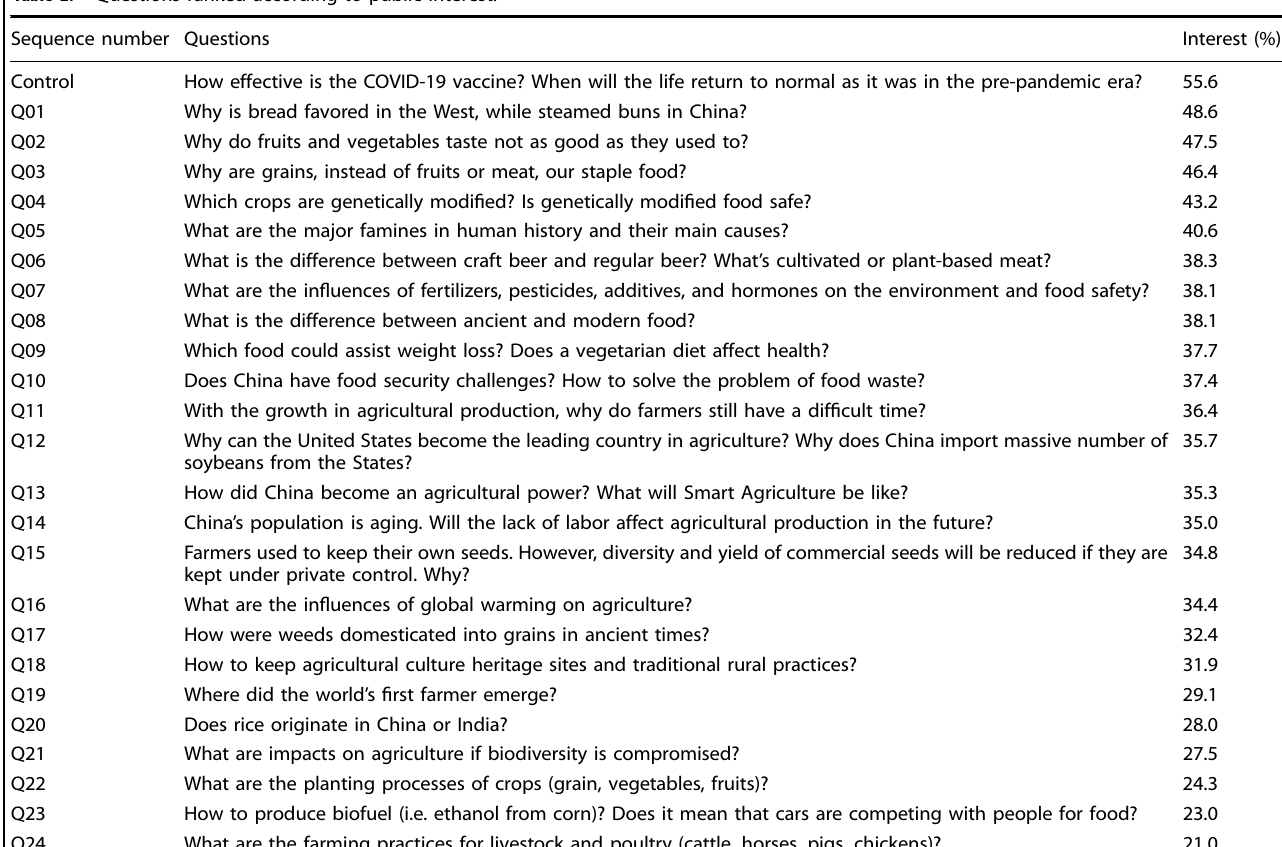
Table 2. Questions ranked according to public